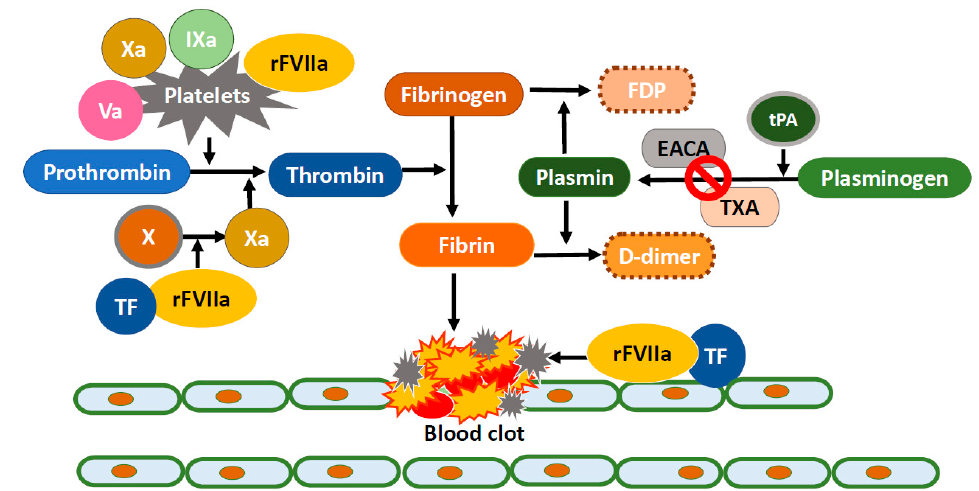
Figure 1. Coagulation and fibrinolytic cascades and the mechanisms of hemostatic agents. TXA prohibits conversion of plasminogen into plasmin inhibiting fibrinolysis and stabilizes blood clots [62]. In addition to intravenous use, intrapulmonary or aerosolized TXA has been used for DAH [63–65]. Nebulized TXA led to complete or near cessation of bleeding in 10/18 pediatric patients with DAH [65], and recently, Neil et al. published a successful treatment outcome in 19 pediatric patients with DAH: 18 out of 19 patients had stopped bleeding after TXA inhalation [64]. However, TXA therapy failed to show significant effect on reducing bleeding-associated mortality in patients with hematologic malignancies [66] but also increased risk of post-operative seizures [67] and showed limited efficacy on profound and recurrent bleedings [65]. EACA, another option for hemostatic treatment, is a lysine analog that binds competitively to plasminogen, blocking plasmino- gen from binding to fibrin and the subsequent conversion to plasmin, resulting in